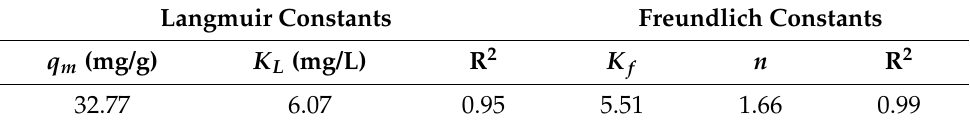
Table 1. Langmuir and Freundlich isotherm constants for the uptake of lead (II) cation at room temperature. Langmuir